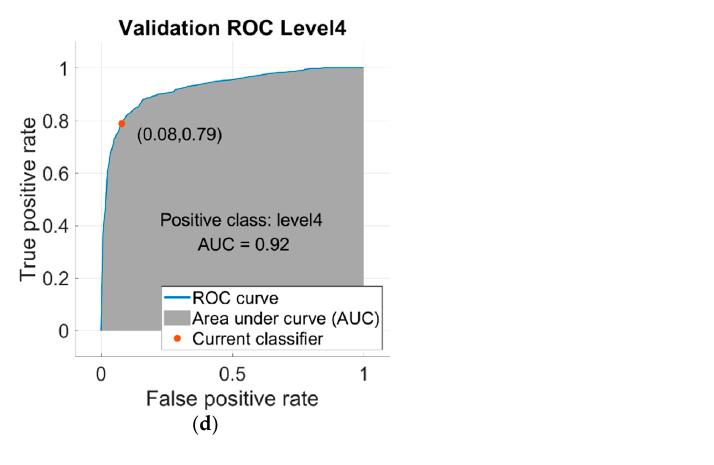
Figure A3. ( a ) Validation curve of “Z” axis level1; ( b ) Validation curve of “Z” axis level2; ( c ) Validation curve of “Z” axis level3; ( d ) Validation curve of “Z” axis level4.